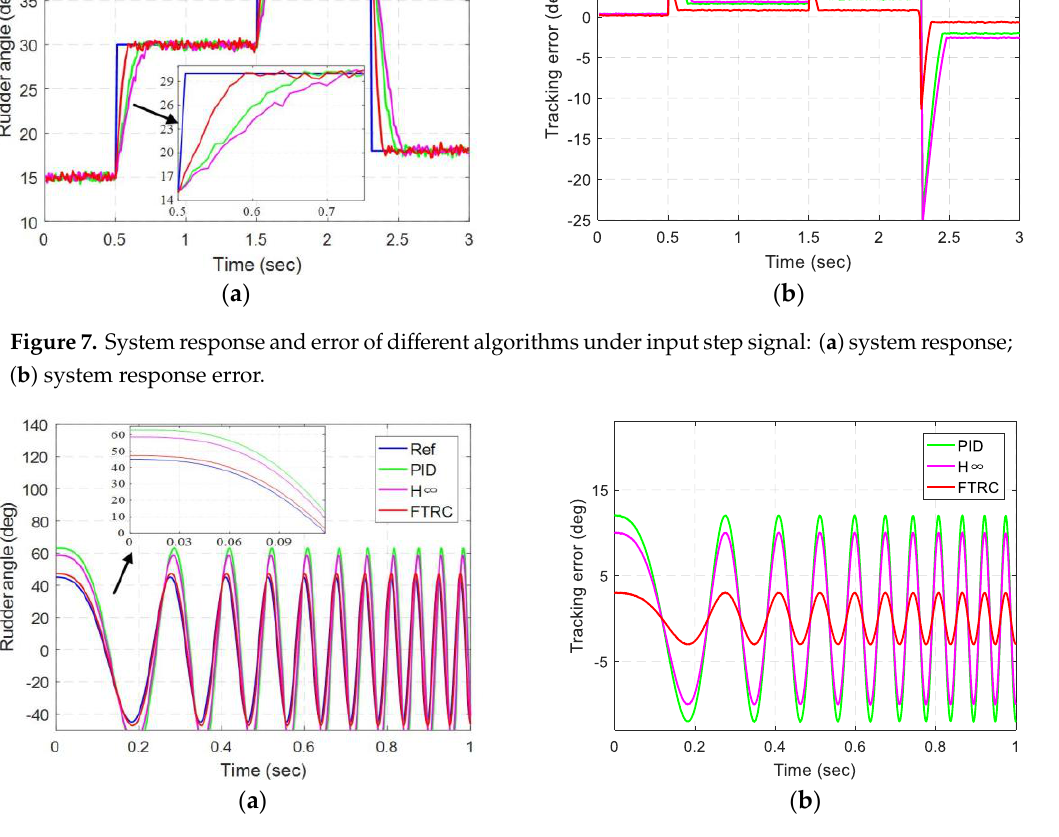
Figure 8. System response and error of different algorithms under chirp signal: ( a ) system response; ( b ) system response error. Table 1. Physical parameter of electric rudder